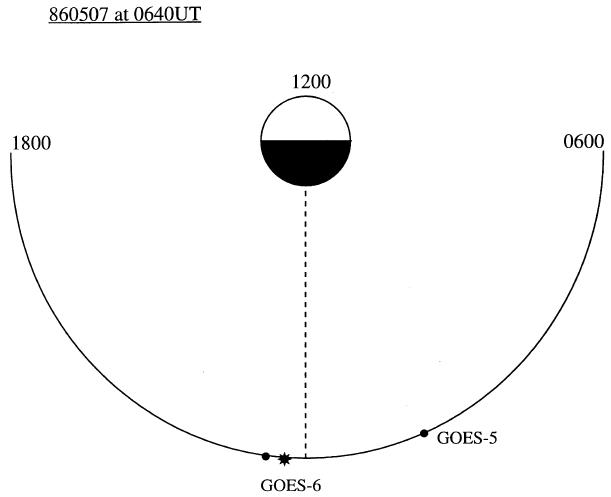
Fig. 9. The position of GOES-5 and GOES-6 satellites is given in a local time versus radial distance representation for the May 7, 1986 event, at 0640 UT when the AL onset is detected. The * point indicates the possible location of the sector of the initial SCW formation